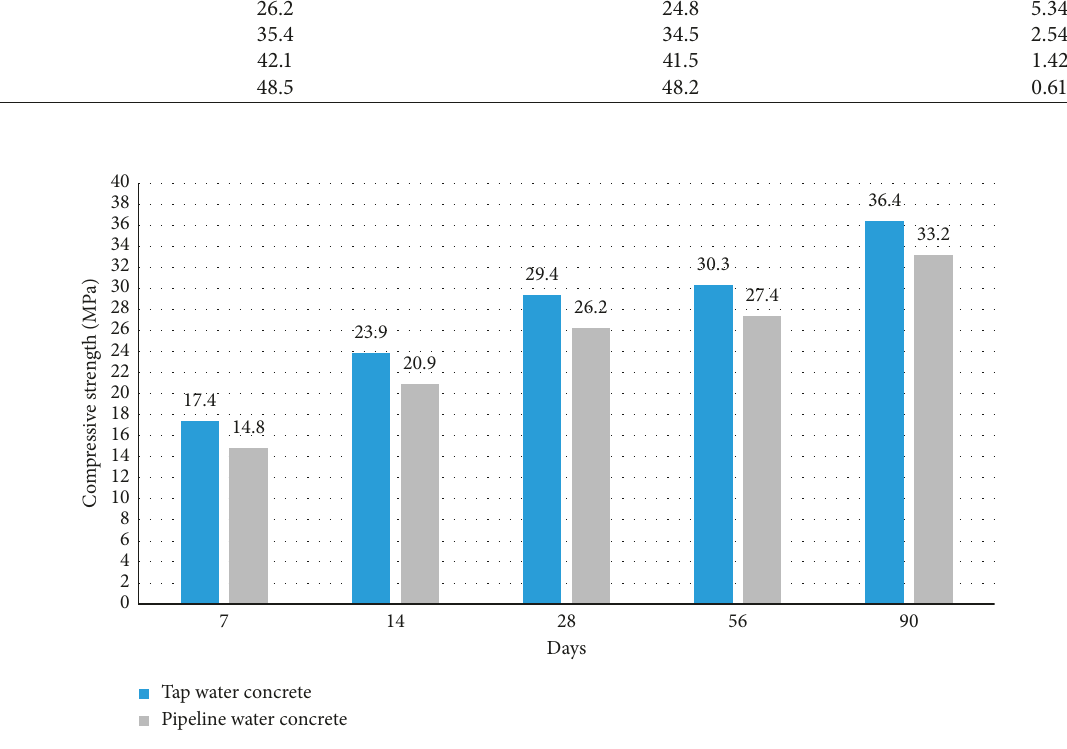
Figure 8: Comparison of compressive strength in tap water concrete and pipeline water concrete.